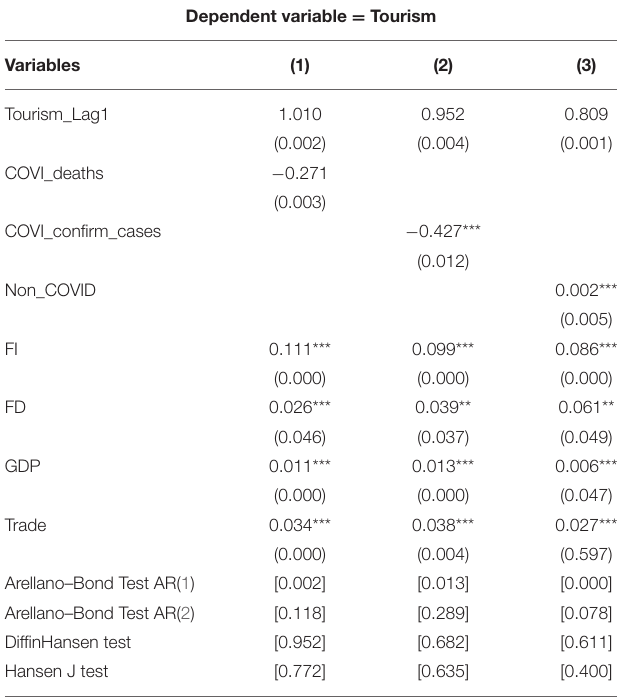
TABLE 2 | Effects of Health crises on tourism in developed